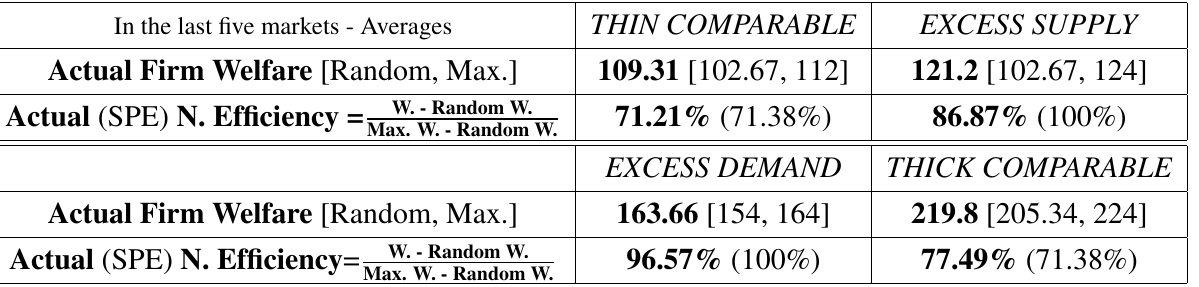
Table 8. Average of the sum of firm payoffs in the last five markets, with random match payoffs and maximum firm payoffs under full matchings in parentheses, and normalized efficiency, with the theoretical SPE prediction in